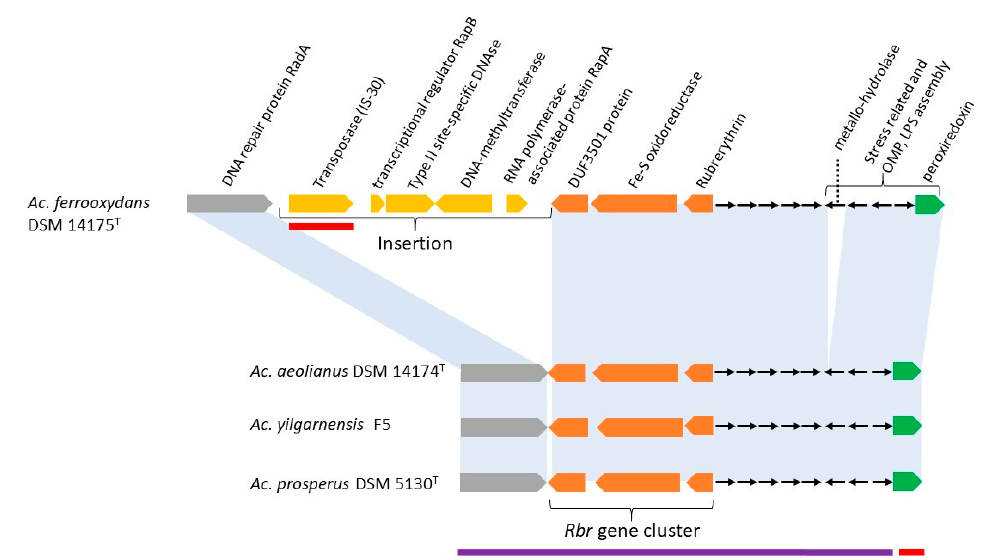
Figure 3. Genomic context of rubrerythrin ( rbr ) and neighboring genes in the four species of Acidihalobacter . Red underlining = genes with similarity to orthologs in acidophiles; purple underlining = genes with similarity to orthologs in neutrophilic halophilic and halotolerant organisms or to other non-acidophiles (Supplementary File 2).